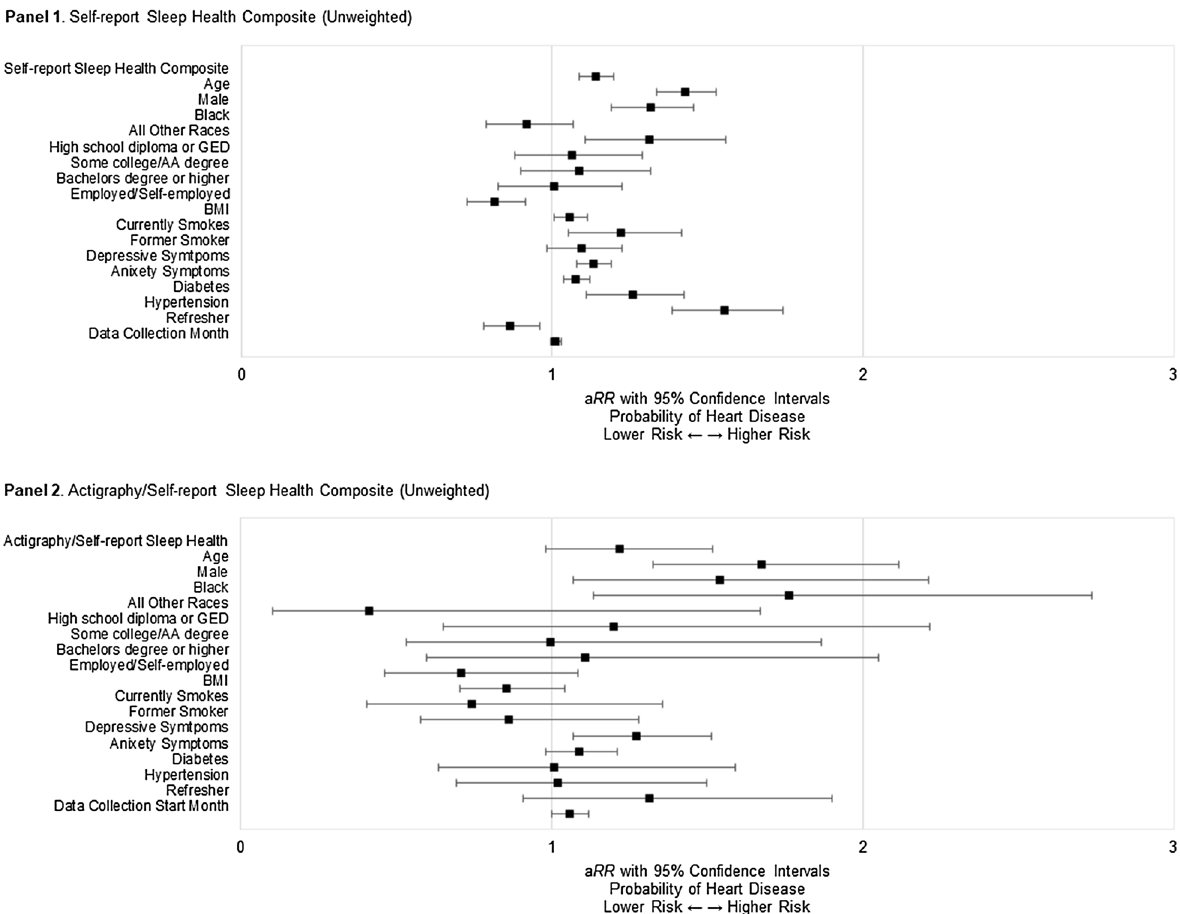
Figure 3. Results of modified Poisson analyses displaying the relative risk of heart disease by unweighted sleep health composites and